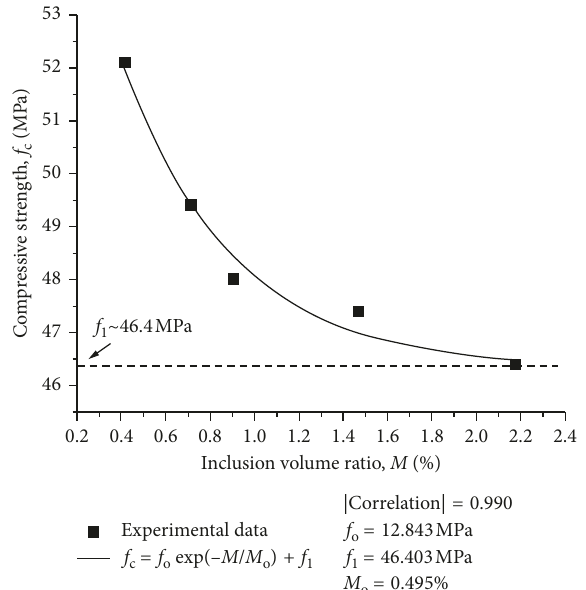
Figure 9: The decreasing sequence of compressive strength of ce- ment mortar in dependence on inclusion volume ratio. The ex- perimental data are identical to those presented in Figures 7 and This can be easily verified by inserting M 3 . 77% into max (cid:31) equation (11). The resulting value of compressive strength f M 46 . 409 MPa corresponds almost exactly to the c ( max ) (cid:31) optimized value f 46 . 403 MPa. 1 (cid:31)